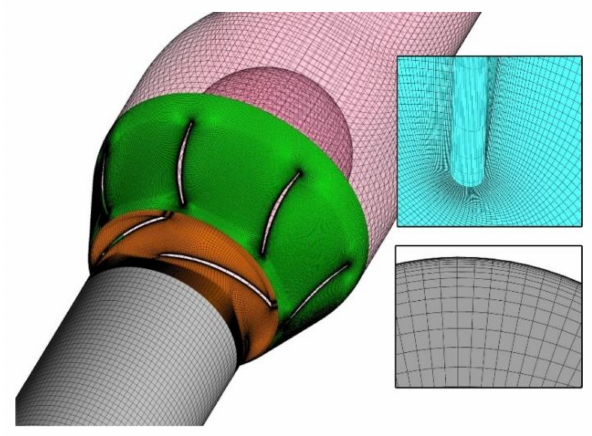
Figure 2. Hexahedral mesh of computational